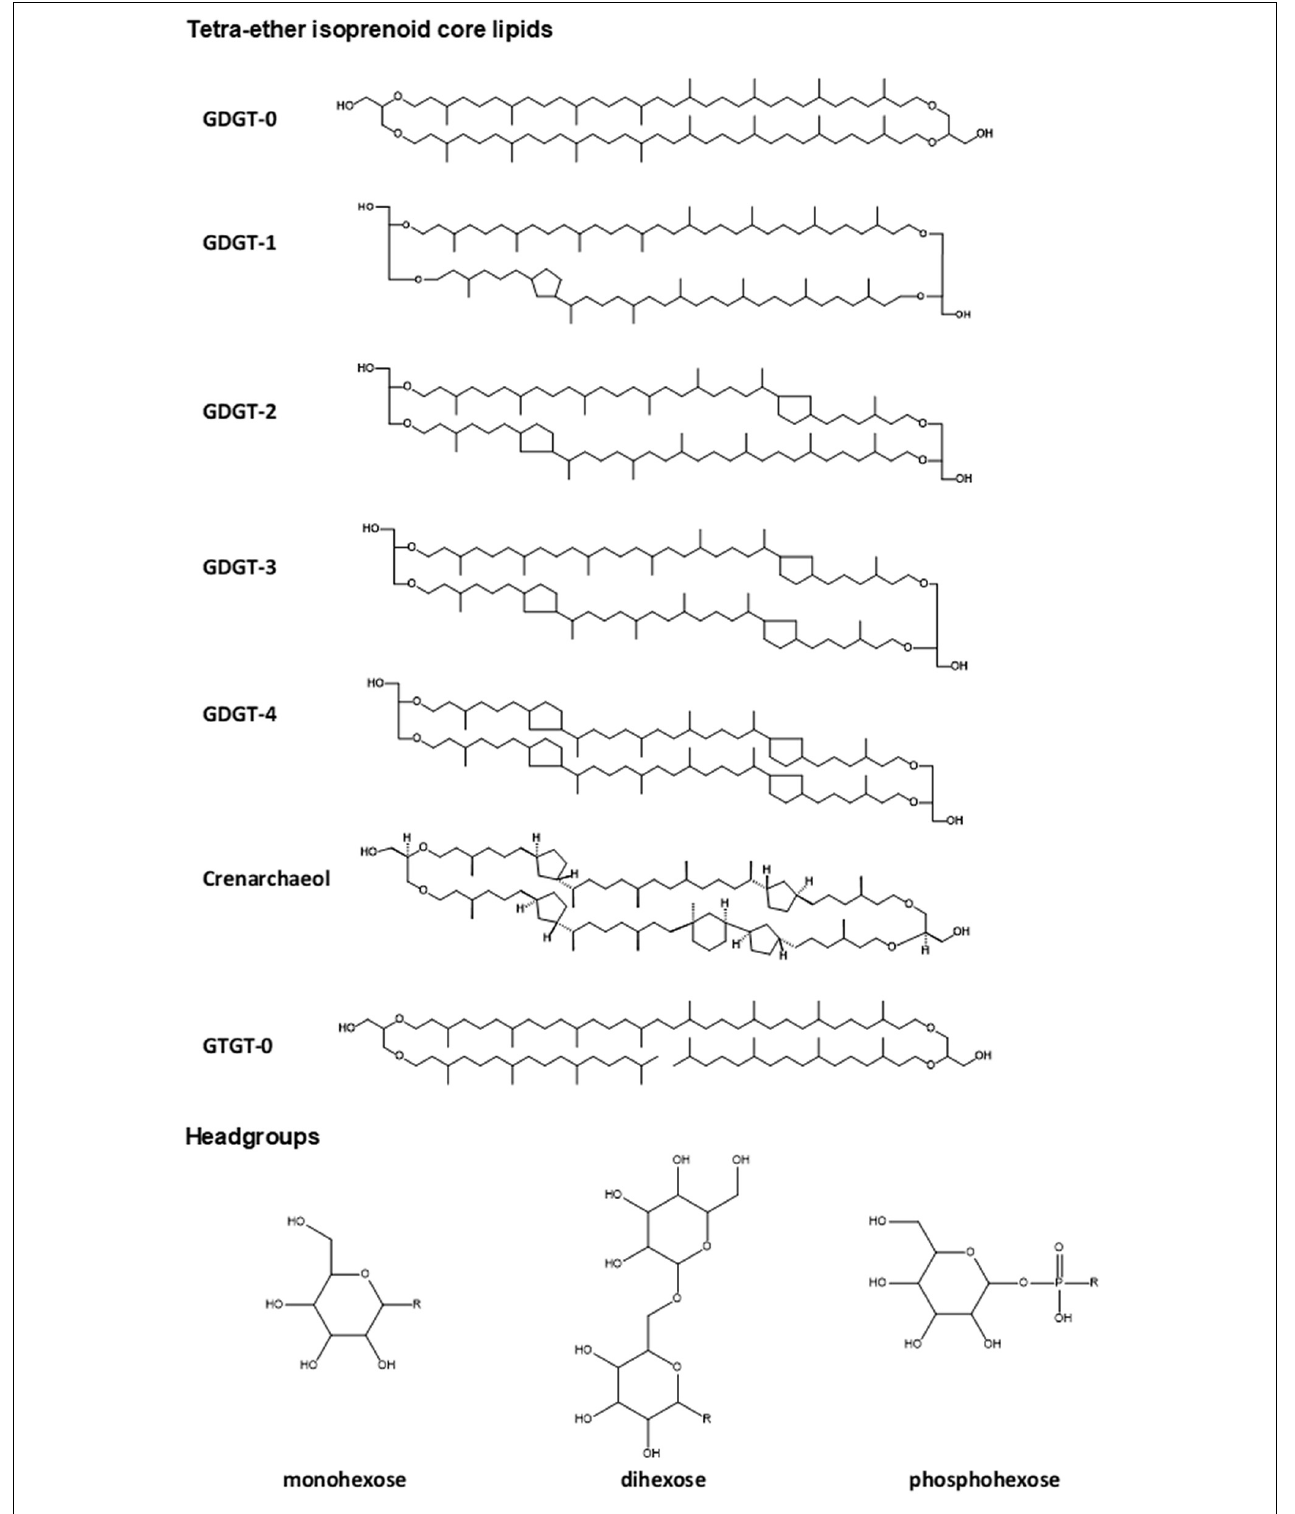
FIGURE 1 | Structures of common lipids found in N. maritimus . These lipids are typically composed of a diether or tetraether isoprenoid core with one or two headgroups linked to the terminal hydroxyl moieties. Correct stereochemical form was drawn for crenarchaeol (as it is a unique GDGT compound) but not for all other compounds to avoid exhaustive use of